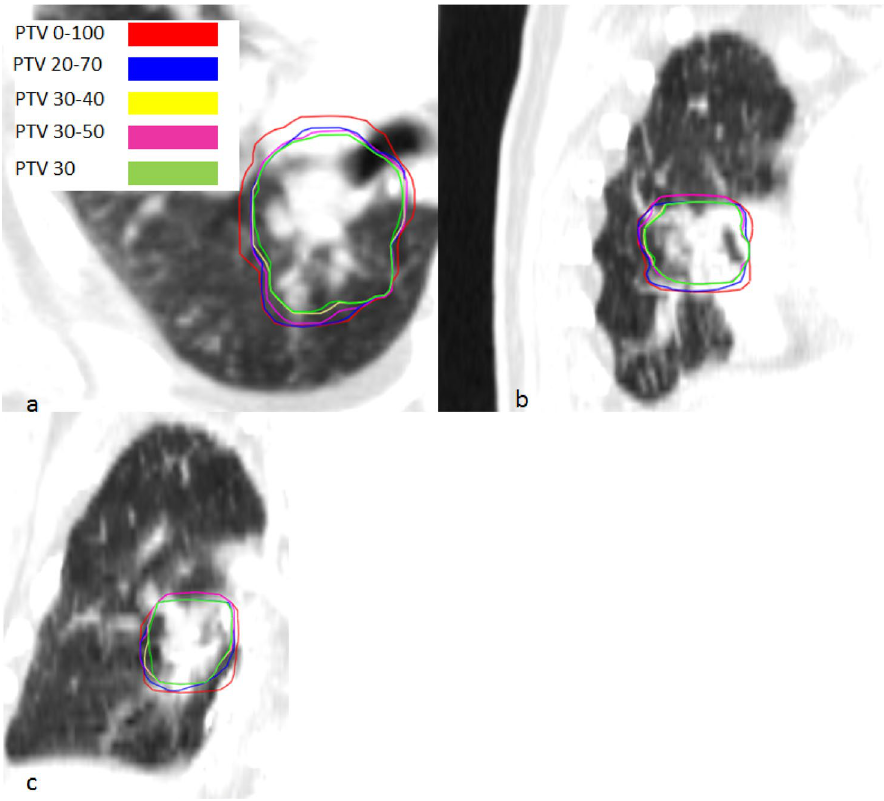
Figure 3. PTV contours for different gating window sizes for patient case 7 in CTs in transversal ( a ), sagittal ( b ) and coronal ( c ) view.